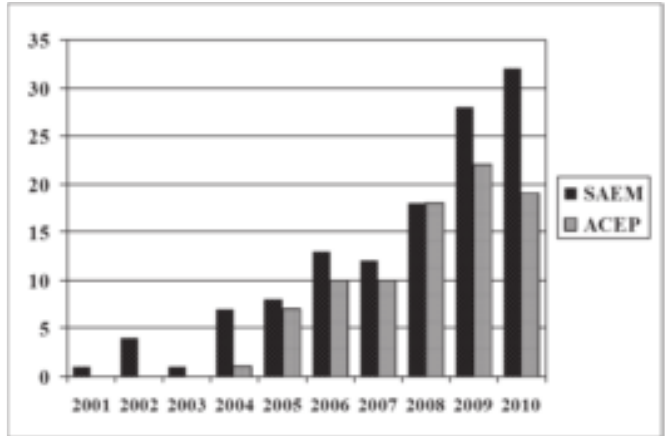
Figure 3. Number of sepsis abstracts at SAEM and ACEP